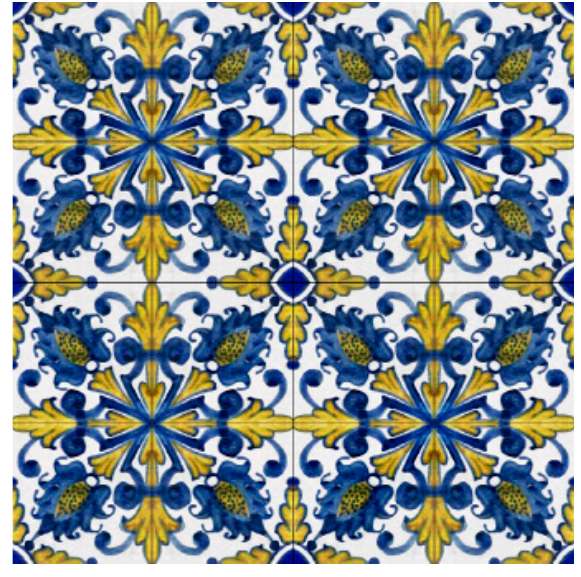
FIGURE 9 | The ‘corncob’ pattern